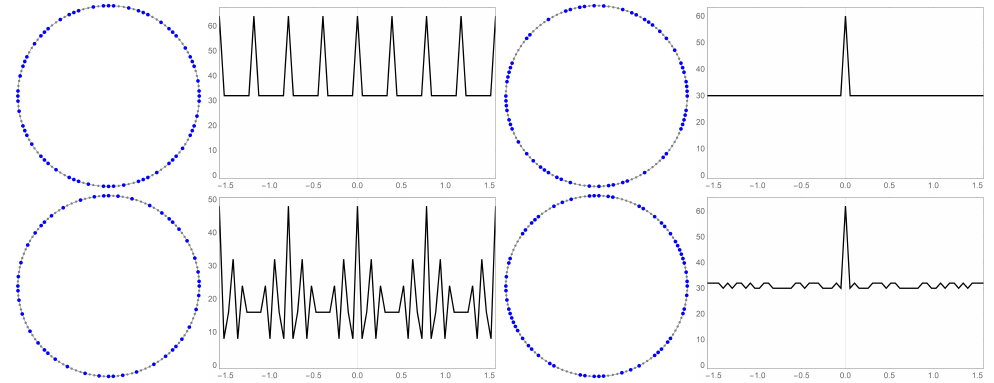
Figure 14. Fiber position diagrams and their corresponding autocorrelations for p = 56 ( top left ), p = 59 ( top right ) which is non-Pythagorean, p = 60 ( bottom left ), and p = 61 ( bottom right ), which is Pythagorean. It is difficult for the eye to discern subtle details in the structure of the fiber position diagrams, especially for large p values. The autocorrelations, however, are quite distinct for these four similar